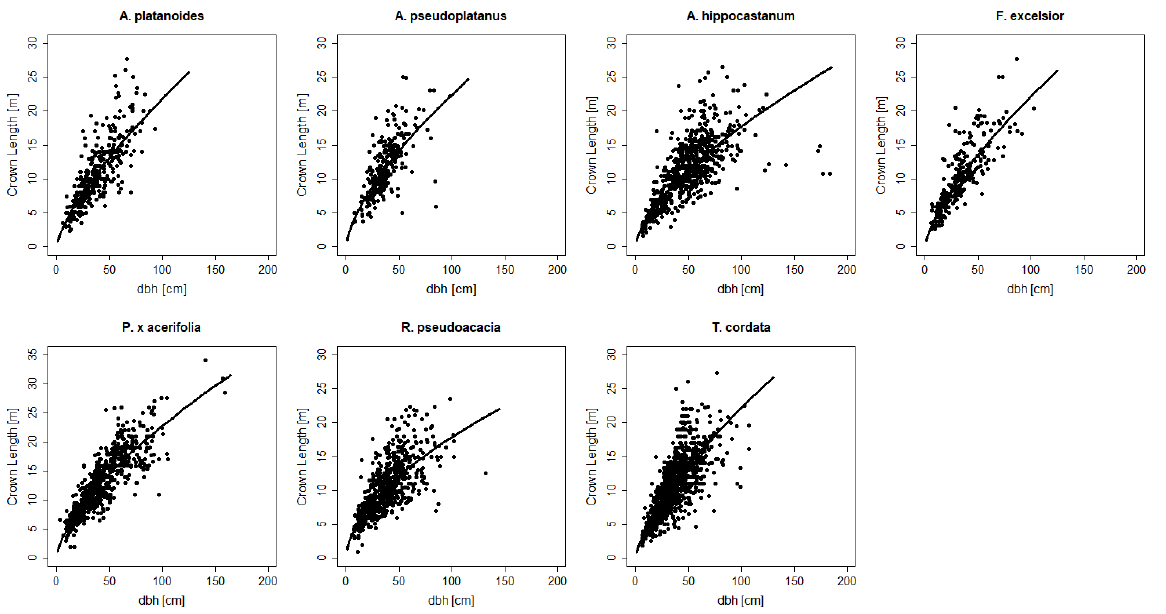
Figure 3. Crown radius and diameter at breast height relationship for seven common urban tree species.